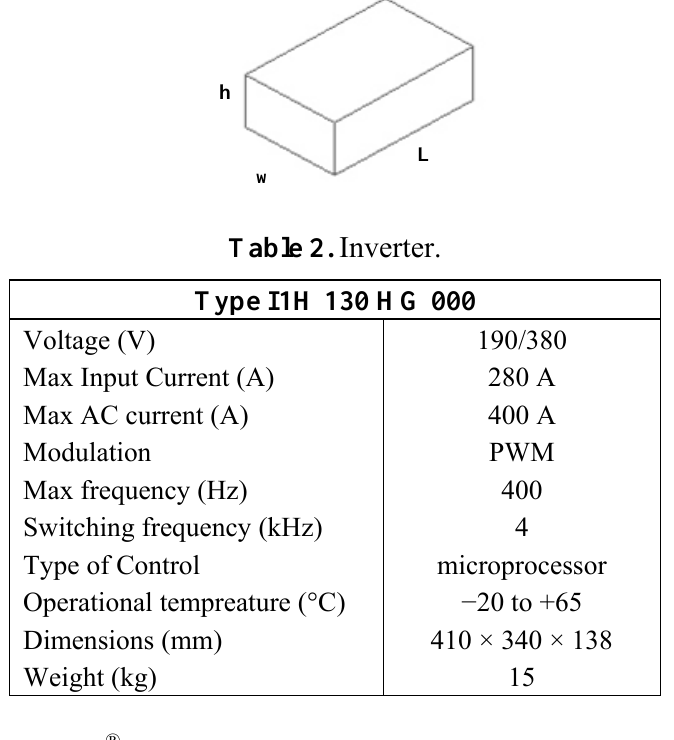
Figure 4. GENESIS ® battery module; L = 200 mm, w = 170 mm, h = 170